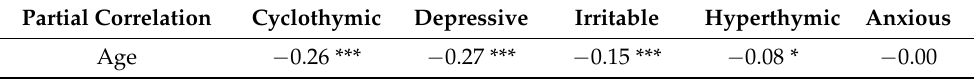
Table 5. Partial Spearman’s correlation between 5 temperaments and age. Partial